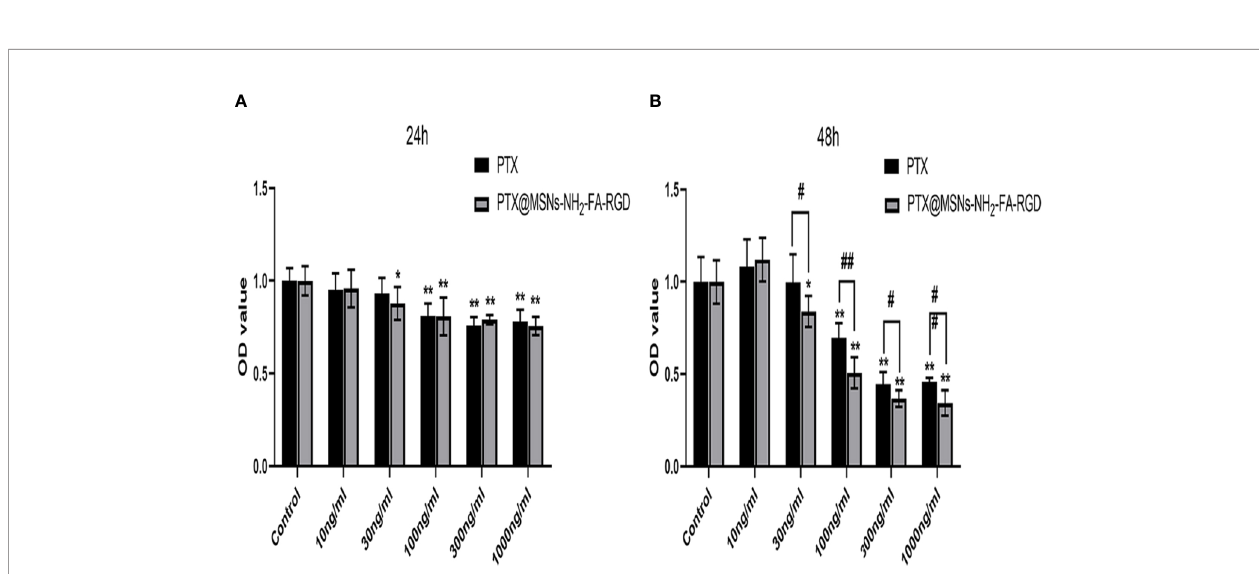
FIGURE 10 | Cytotoxicity for free PTX and PTX@MSNs-NH 2 -FA-RGD at different concentrations (ng·ml -1 ) against MCF-7 cells evaluated at 24 h (A) and 48 h (B) . (** p < 0.01, * p < 0.05 as compared with the data of control group; ## p < 0.01, # p < 0.05 when PTX group compared with PTX@MSNs-NH 2 -FA-RGD at the same concentration).